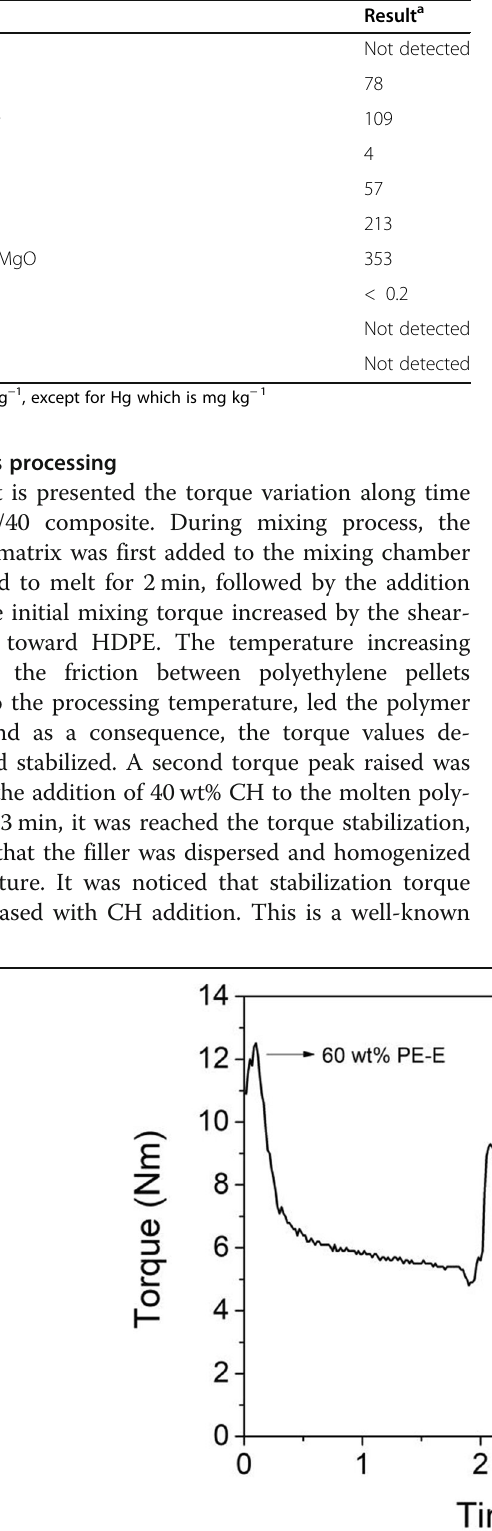
Table 3 Chemical composition of coffee husk used in this work